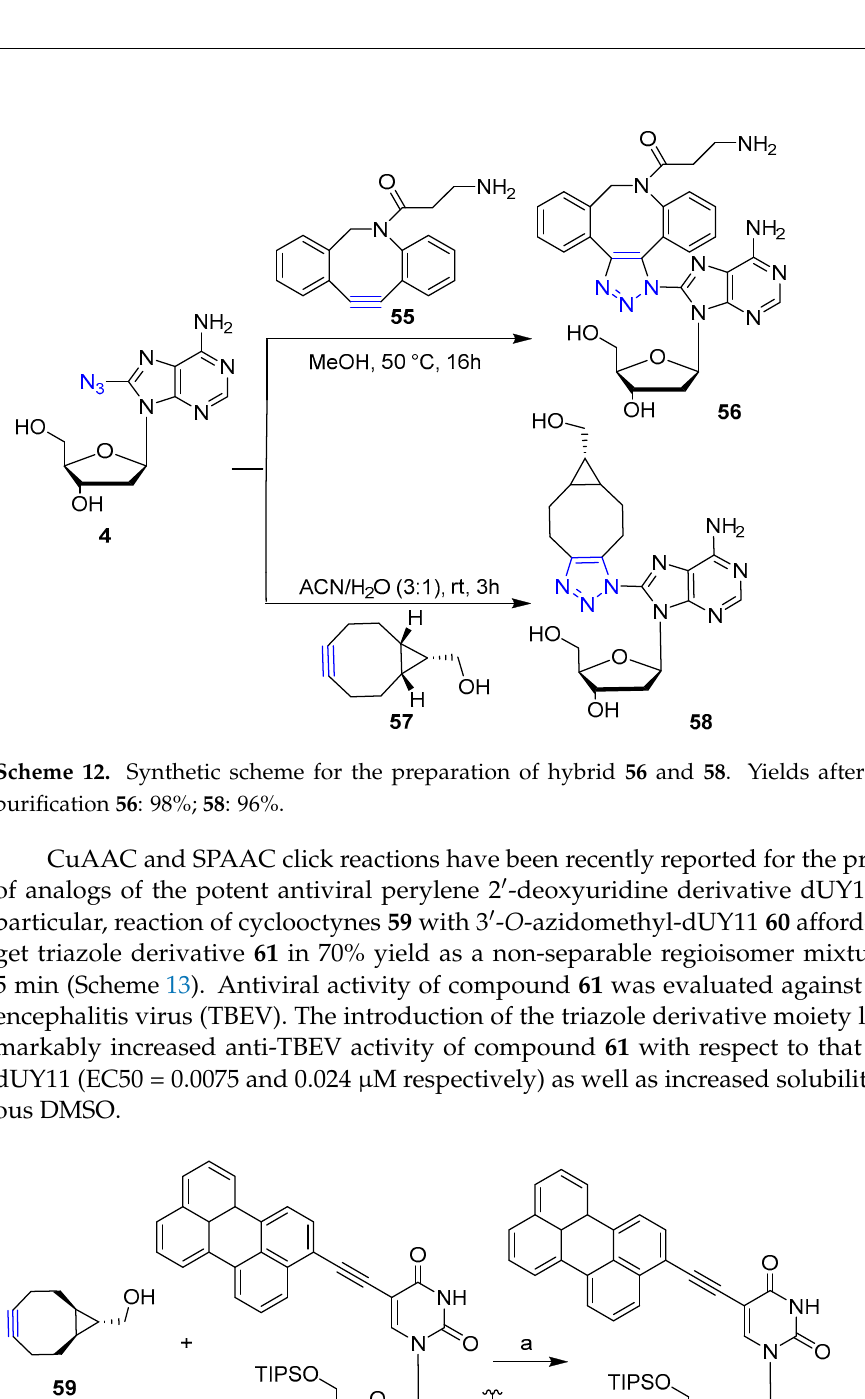
10 of 29 Scheme 11. Reaction conditions: ( a ) Ph-Me, 110 °C, 24 h. In recent years, azido nucleosides have been also subjected to SPAAC reaction for the